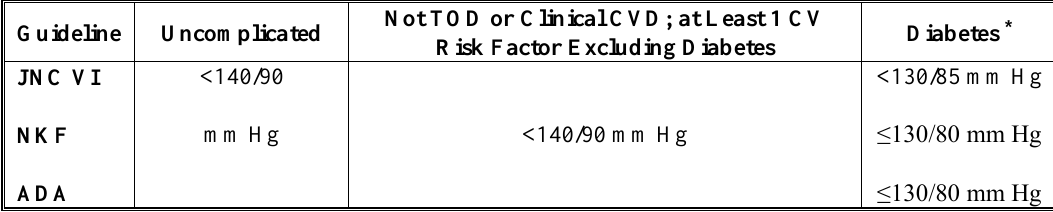
NKF indicates National Kidney Foundation; ADA, American Diabetes Association. TOD, target organ damage; JNC, Joint National Committee; CVD, Cardiovascular disease. *JNC VI BP goal also recommended for those with TOD or clinical